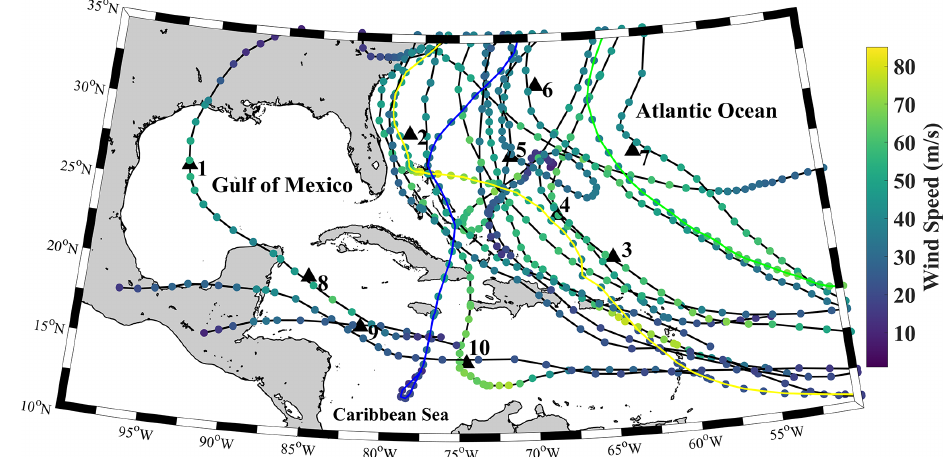
Figure 1. Geographic map of the Caribbean Sea, Gulf of Mexico, and western Atlantic Ocean with the best tracks of each studied hurricane and National Data Buoy Center (NDBC) buoy locations (black triangles). Best tracks from model training hurricanes are given in black, while the test best tracks are given in yellow, blue, and green for Hurricanes Dorian, Sandy, and Igor, respectively. Numbered from 1–10, the NDBC buoys employed are buoys 42002, 41010, 41043, 41046, 41047, 41048, 41049, 42056, 42057, and 42058,